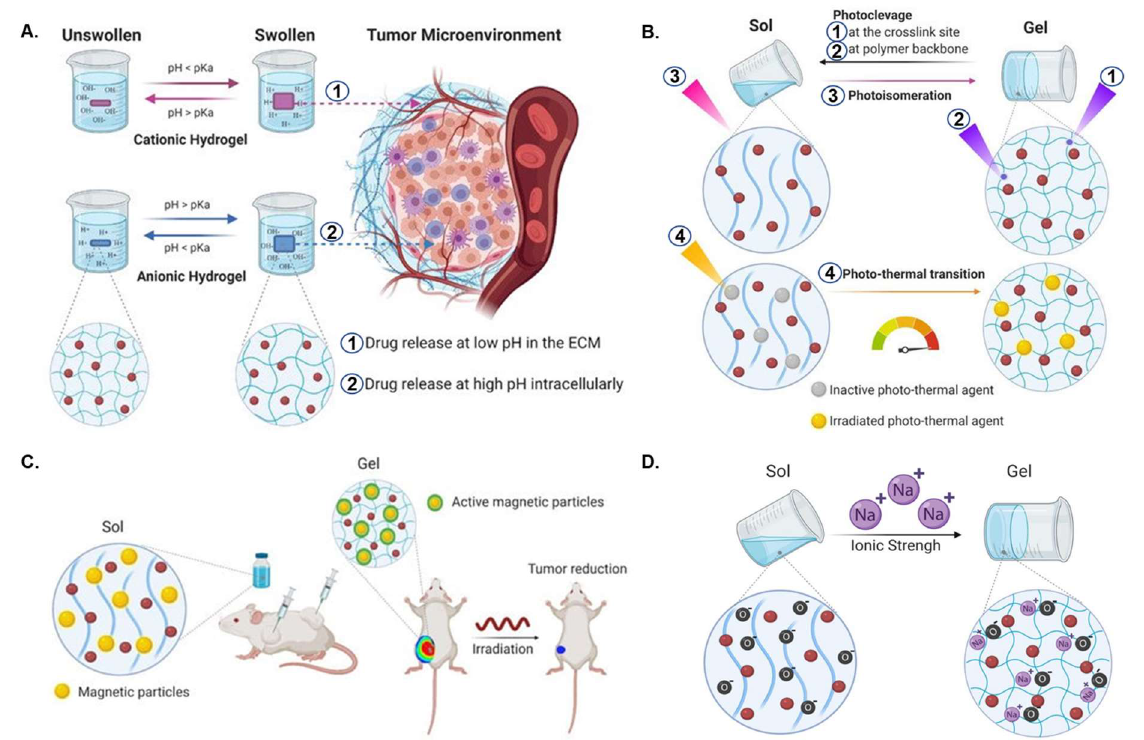
Figure 2. ( A ) Schematic illustration of pH-responsive scaffolds. (1 and 2). Site-specific chemotherapeutic releases at low and high pH, respectively. ( B ) Photo-induced cleavage (1 and 2), isomerization (3), and heat change (4) in chemotherapy drug-loaded light-sensitive scaffolds. ( C ) Magnetic scaffolds for tumor suppression. ( D ) Ion force-triggered scaffolds. Red-colored balls represent anticancer drugs. Reproduced with permission [8]. Copyright 2021, MDPI.